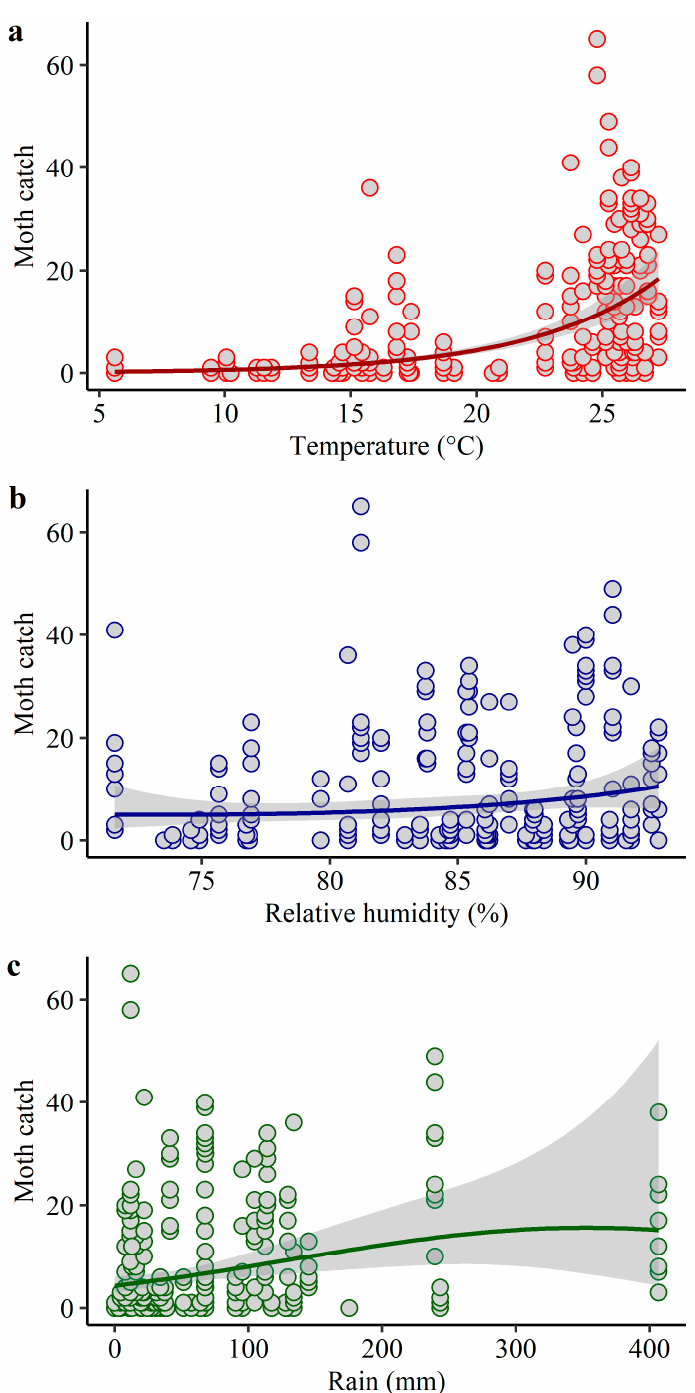
Figure 6. Expected H. zea moth catch as a function of ( a ) temperature, ( b ) relative humidity, and ( c ) rainfall in Santa Rosa/Escambia counties, Florida. Solid lines indicate the fitted model (GLM with a negative binomial error distribution) and grey bands indicate the confidence intervals. Circles represent the total number of insects collected for two years using sex-pheromone trapping (n = 335).